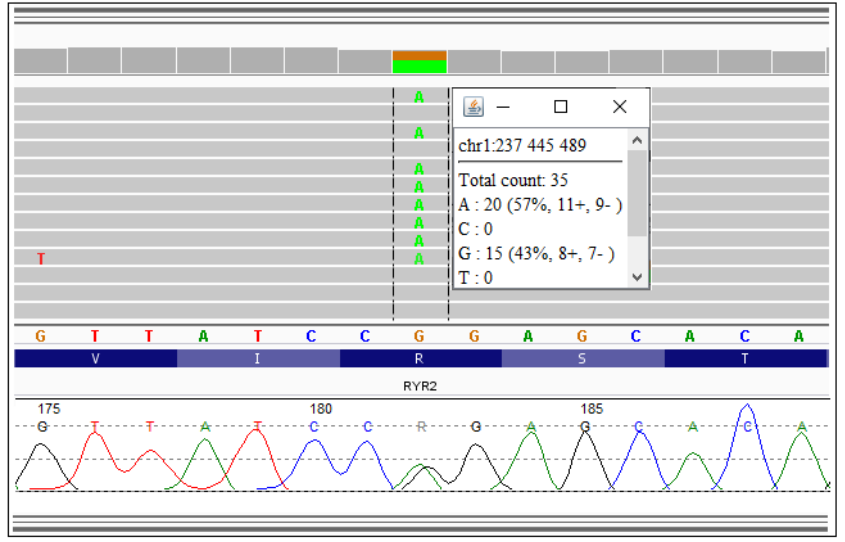
Figure 3. Result of the next generation sequencing and electropherogram showing a variant p.Arg420Gln in the RYR2 gene.